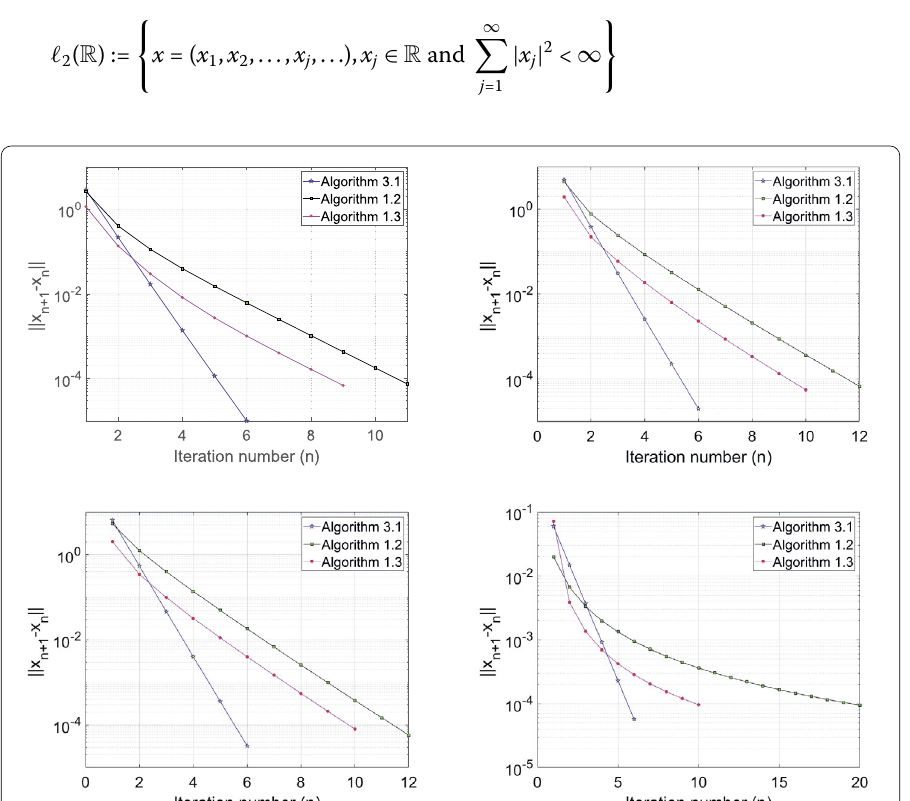
Figure 1 Example 4.1, top left: Case I; top right: Case II; bottom left: Case III; bottom right: Case